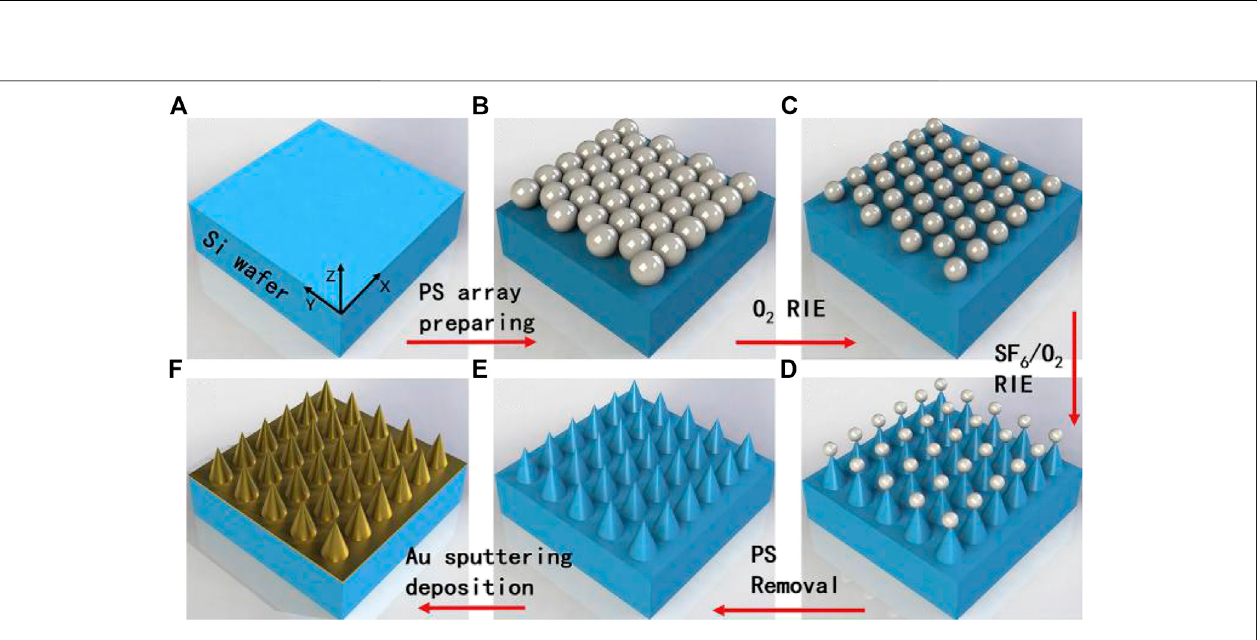
FIGURE 5 | The fabrication of nano cone array with Au layer. Source : Reproduced from Ref.